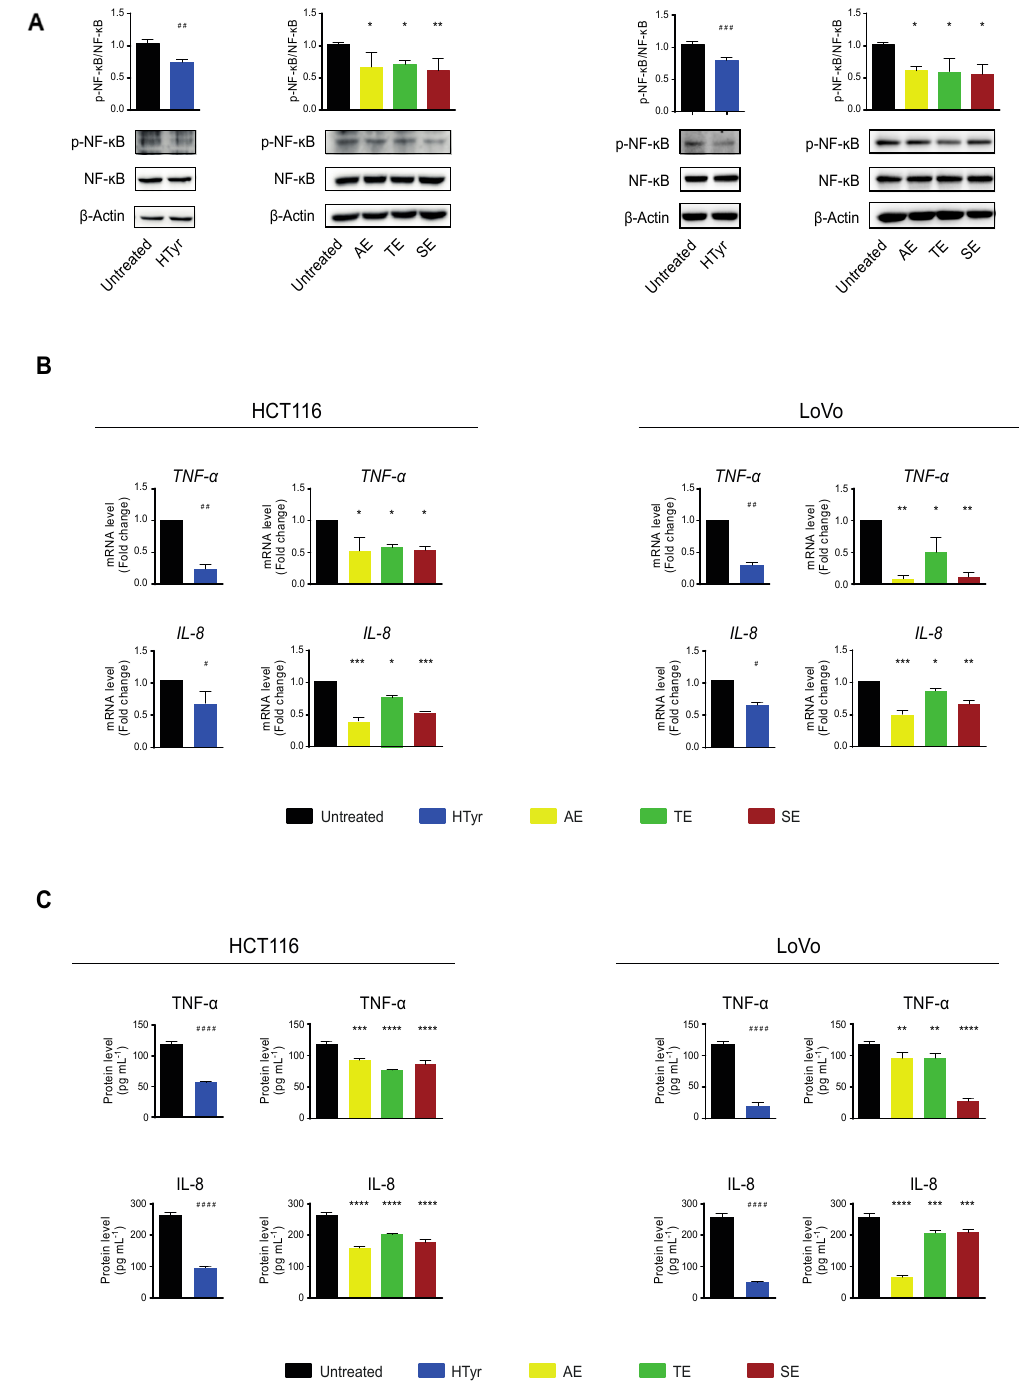
Figure 6. Hydroxytyrosol and the OPWPs extracts exhibit anti-inflammatory properties in colorectal cancer cells. ( A ) Western blot analysis of the phosphorylation levels of NF- κ B normalized to total NF- κ B in extracts from HCT116 and LoVo cells treated with HTyr or with the various extracts as indicated in the text for 72 h, with respect to untreated cells. β -Actin is shown as loading control. ( B ) qRT-PCR analysis of TNF- α and IL-8 mRNAs in HCT116 and LoVo cells treated as in ( A ) and compared to untreated cells. ( C ) TNF- α and IL-8 protein levels evaluated in the culture medium of HCT116 and LoVo cells treated as in ( A ) with an ELISA assay. Statistical significance is considered when # p ≤ 0.05, ## p ≤ 0.01, ### p ≤ 0.001, #### p ≤ 0.0001 ( t -test) or * p ≤ 0.05, ** p ≤ 0.01, *** p ≤ 0.001, **** p ≤ 0.0001 (ANOVA with Dunnett’s